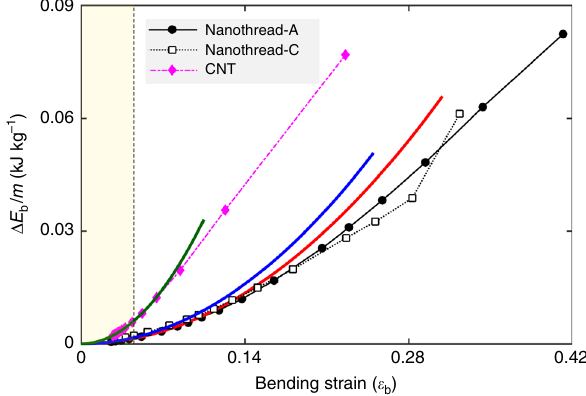
Fig. 2 Bending strain energy density as a function of bending strain. Solid lines are the corresponding fi tting curves based on Hooke ’ s